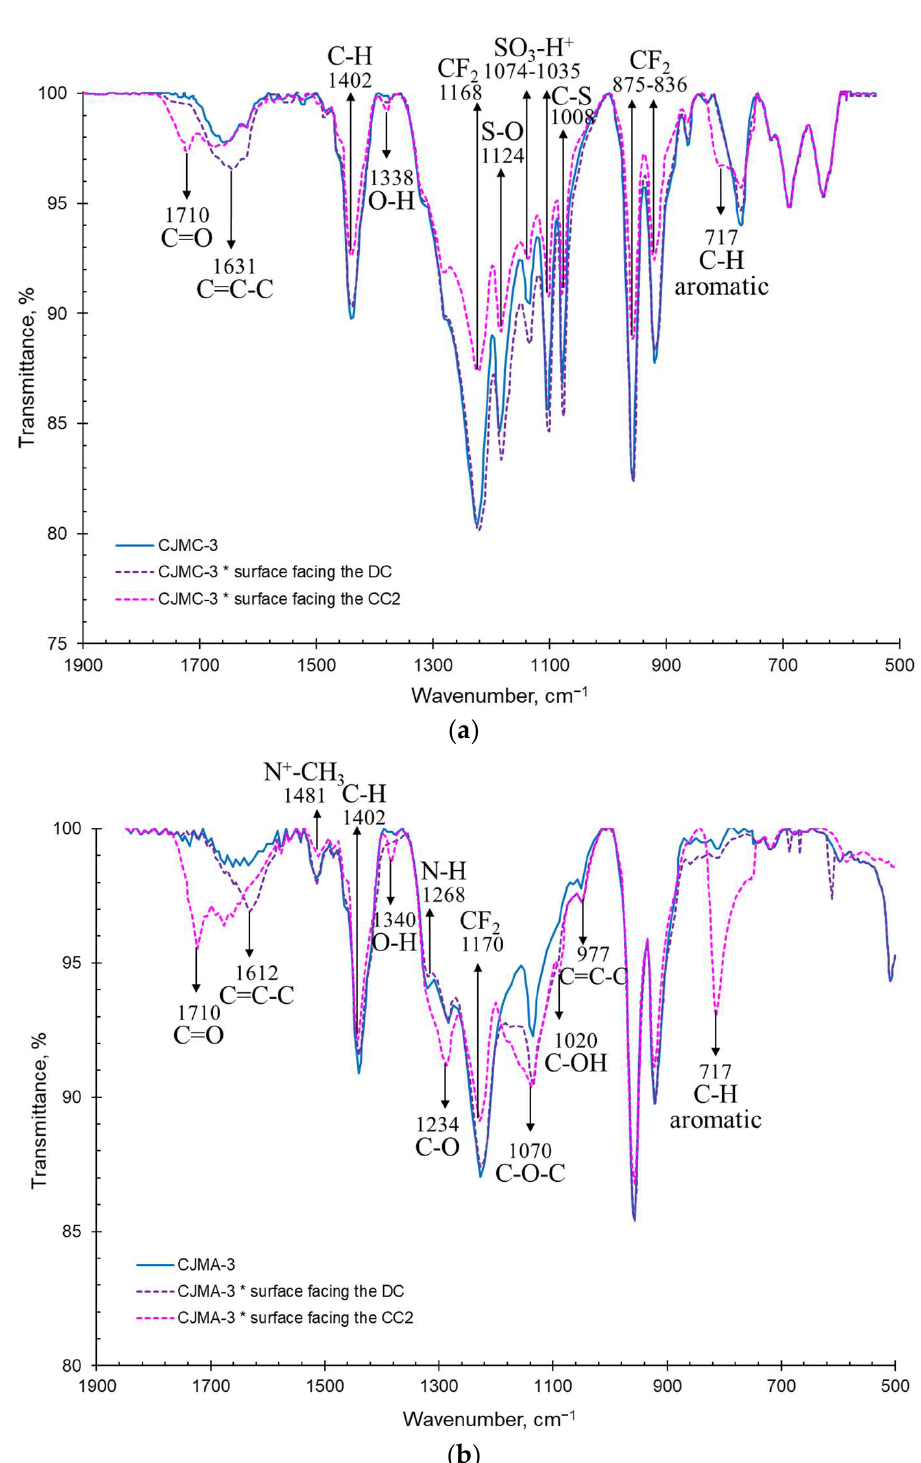
Figure 6. IR spectra of CJMC-3 ( a ) and CJMA-3 ( b ) membranes before and after ED.